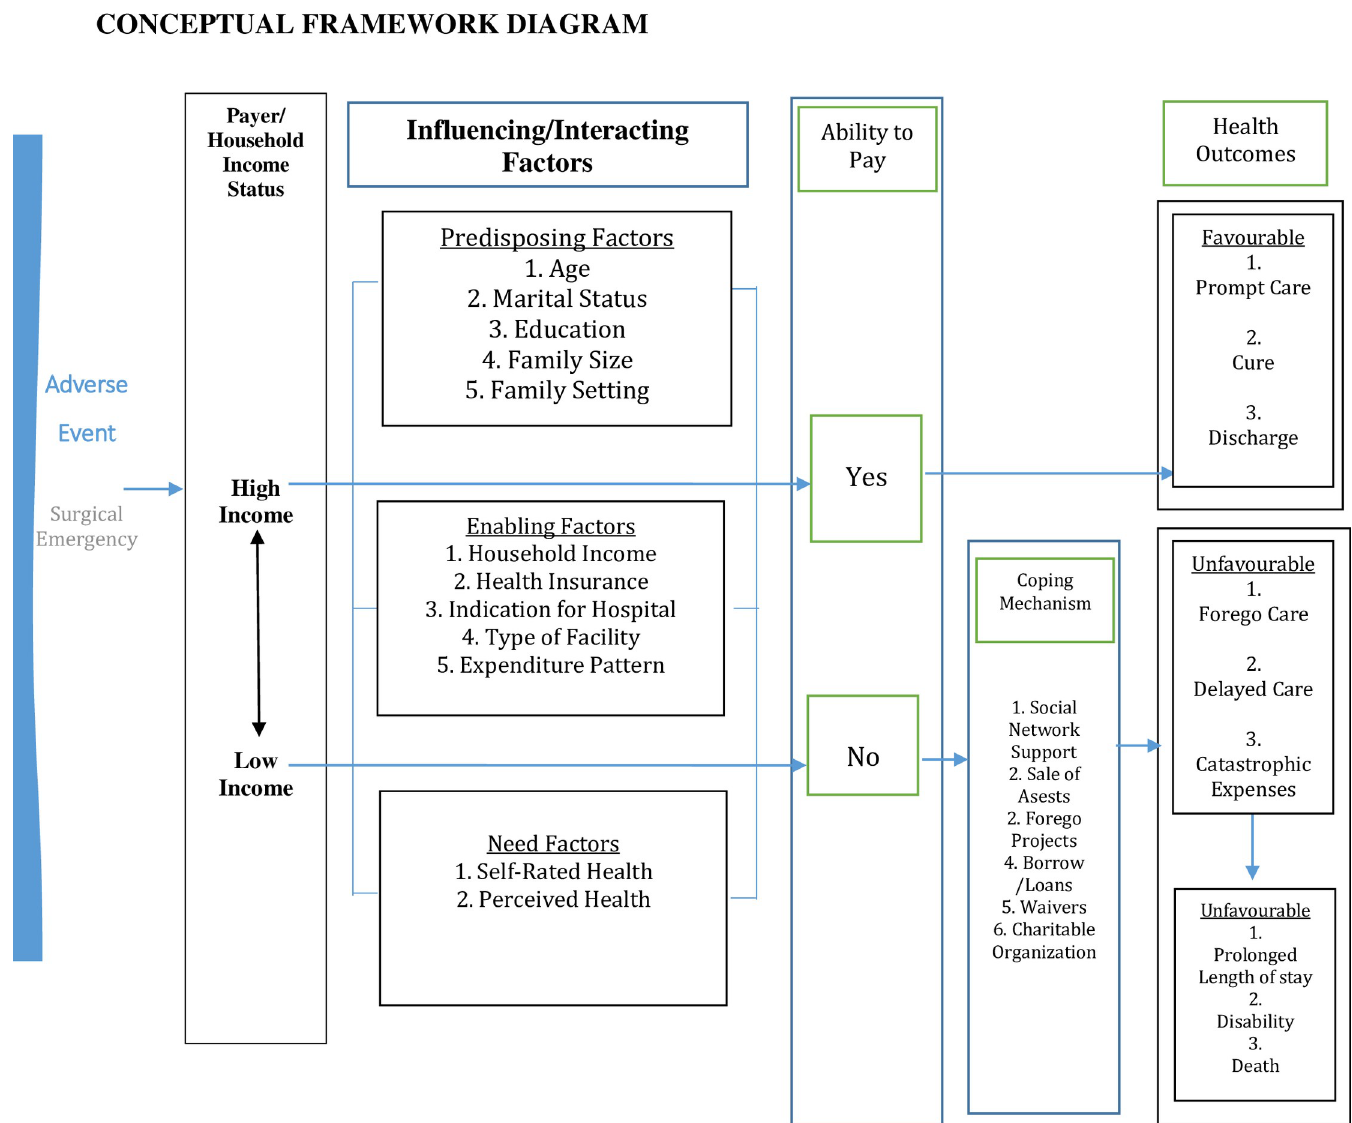
Fig 1. Conceptual framework for patterns of expenditure, coping mechanism among households admitted for emergency surgeries in Ibadan, Nigeria. Adapted from Wilkes et al. (1997) [30] pp3; Tseng & Khan 2015 [31] pp3 and Wild & Hanes (1976) [32].